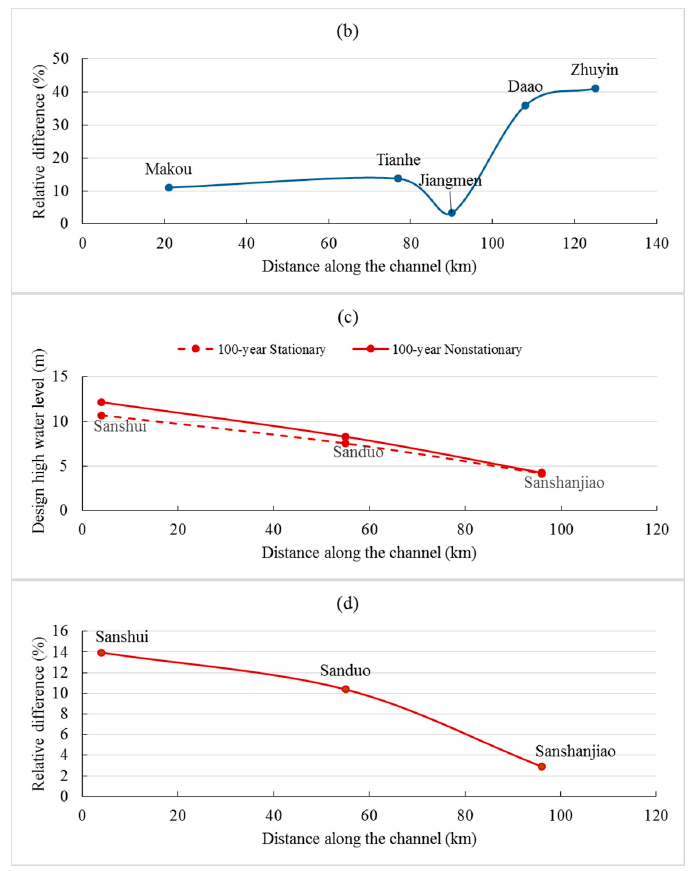
Figure 7. Flood line difference in river channels: ( a ) difference in Makou–Zhuyin Channel; ( b ) relative difference in Makou–Zhuyin Channel; ( c ) difference in Sanshui–Sanshanjiao Channel; ( d ) relative difference in Sanshui–Sanshanjiao Channel.